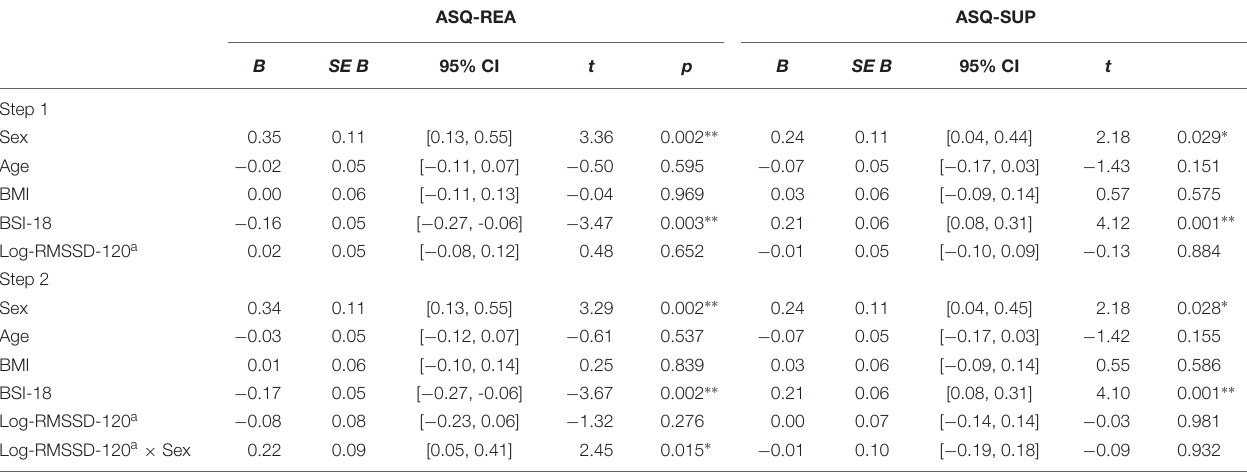
TABLE 3 | Associations between short-term measures of heartrate variability that had been derived from 120 s lasting heartrate recordings and measures of reappraisal and suppression.